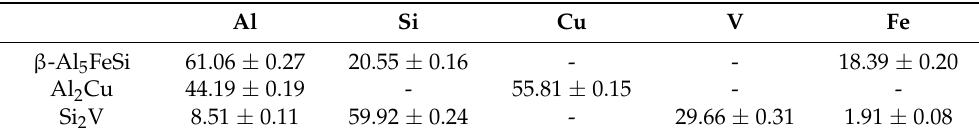
Table 2. Energy dispersive X-ray spectroscopy (EDX) analysis results (at.%) of the compounds shown in Figure 3.